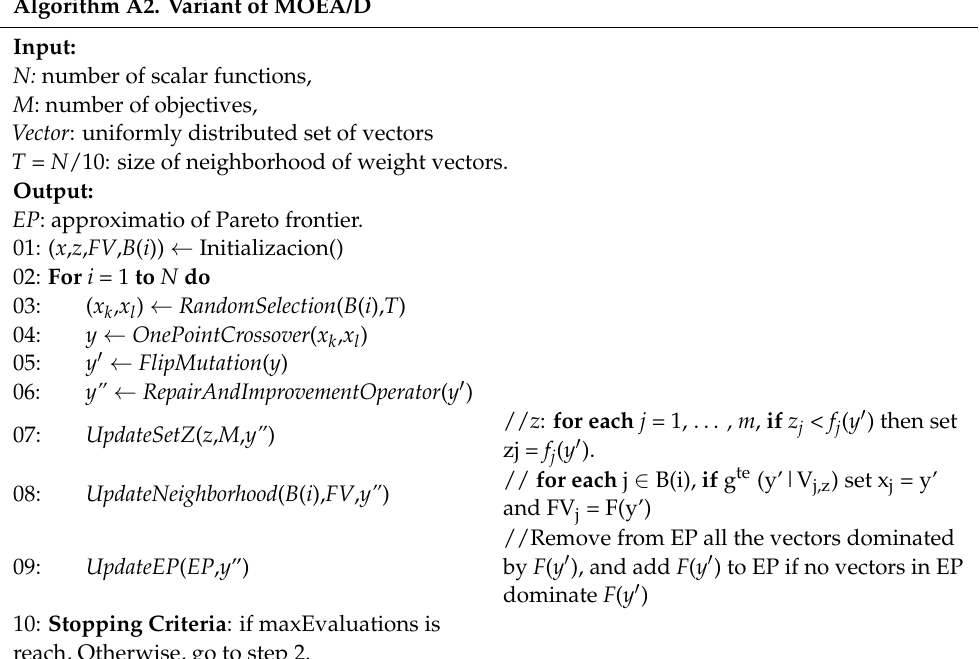
Algorithm A2. Variant of